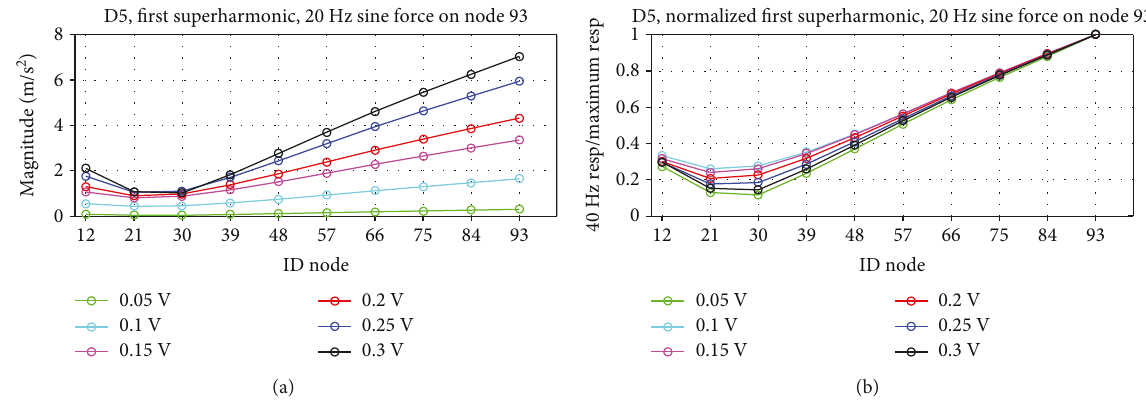
Figure 52: 40 Hz FFT magnitudes, 20Hz sine excitation force applied to node 93, D5 scenario.